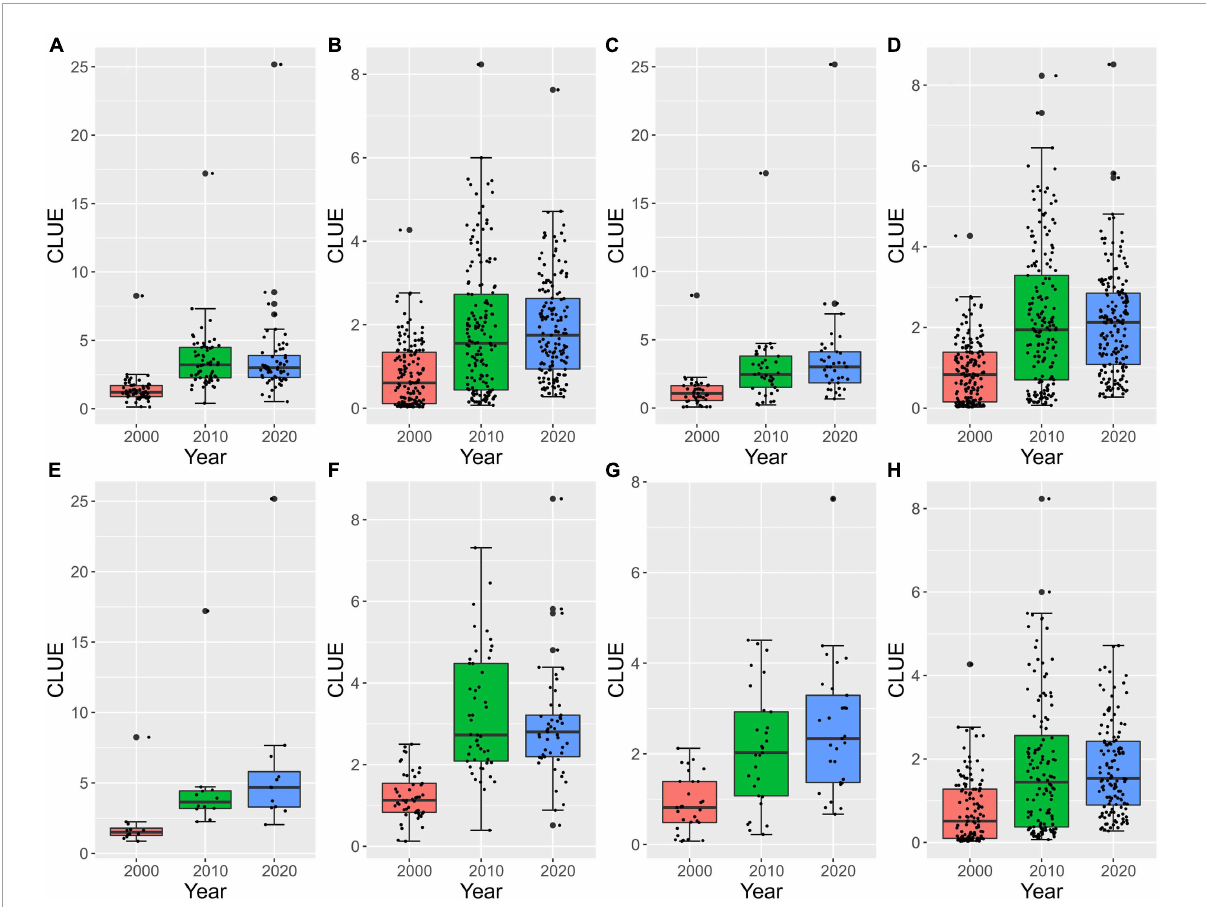
FIGURE6 Regional group differences in CLUE (million RMB per hectare) in the YRD between 2000 and 2020. (A) The core YRD; (B) the peripheral YRD; (C) all central cities; (D) all counties; (E) all central cities in the core YRD; (F) all counties in the core YRD; (G) all central cities in the peripheral YRD; (H) all counties in the peripheral